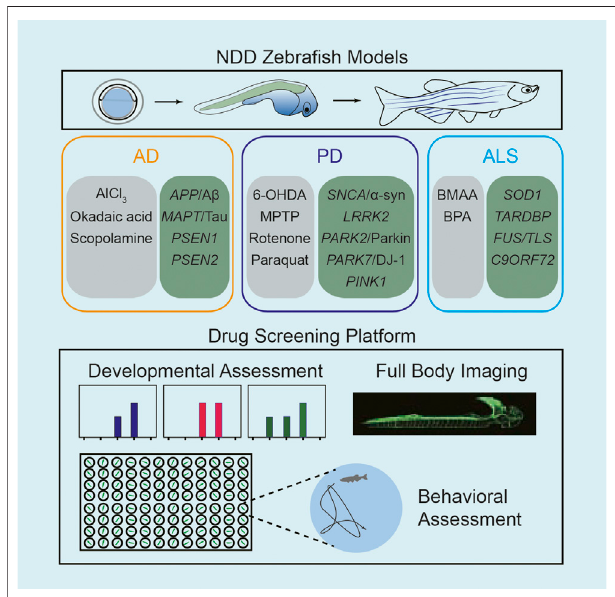
FIGURE 1 | Schematic diagram of the application of zebra fi sh for high- throughput drug screening in NDD research.